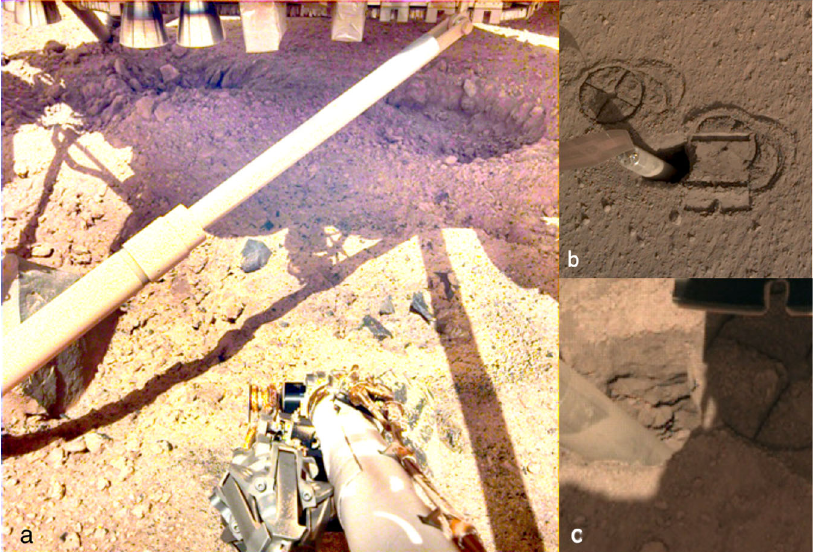
Fig. 8 Images of shallow subsurface structure. a Image shows pits under the lander with spacecraft strut, retrorockets, excavated pits (~10 cm deep, ~50 cm across), dark gray, very fi ne-grained rocks (basalt) and duricrust. Note steep pit walls of soil and clasts in a fi ner-grained matrix, indicating cemented duricrust and clods and fragments of the duricrust that litter the pits and surface. Pulsed retrorockets on the Phoenix lander eroded 5 – 18 cm of material beneath the lander 42 . A contrast stretch has been applied to this image to accentuate details in the shadowed areas. b Image of mole hole and surface after interactions with the HP 3 SSA feet and scoop. Circular cross patterns are imprints of the HP 3 SSA feet in the soil. Smooth, re fl ective rectangular surface is where the fl at base of the scoop (7.1 cm wide) was pressed against the soil, causing a ~5 mm indentation. Note the horseshoe shaped outline of the front blade of the scoop imprint (Fig. 7a). Horizontal troughs near the top and bottom of the scoop imprint are where the front blade of the scoop penetrated into the soil. c ) Image of hole created by the HP 3 mole showing resistant layers in the wall of the pit. These layers have steep edges and overhangs indicating cohesion in the soil. Small rocks appear cemented in a fi ne-grained matrix, similar to the pits beneath the lander. Mole is angled 2.7 cm diameter cylinder (~15°), to the left. at other landing sites (Fig. 8a). In one pit, the exposed subsurface material is poorly sorted with pebbles and cobbles. Two pits have steep slopes (greater than the angle of repose; up to 60° – 70°) composed of small rocks and pebbles cemented in a fi ner-grained matrix (duricrust) 45 . Slope stability analysis indicates that